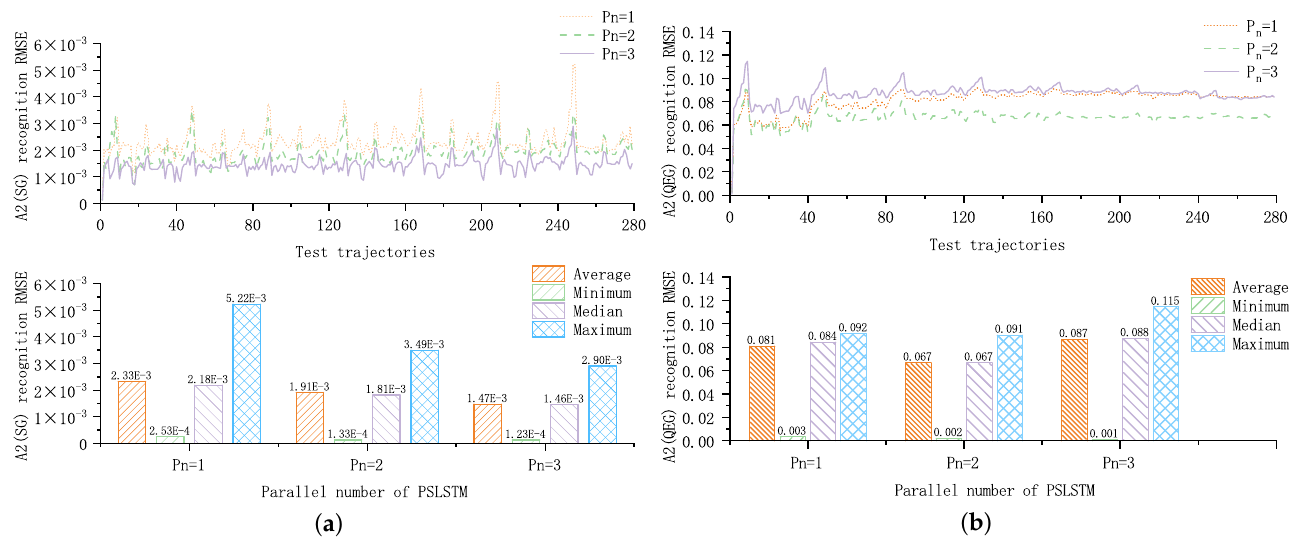
Figure 8. Recognition error of A2: ( a ) is the A2 ( SG ) recognition error curve and ( b ) is the A2 ( QEG ) recognition error curve.